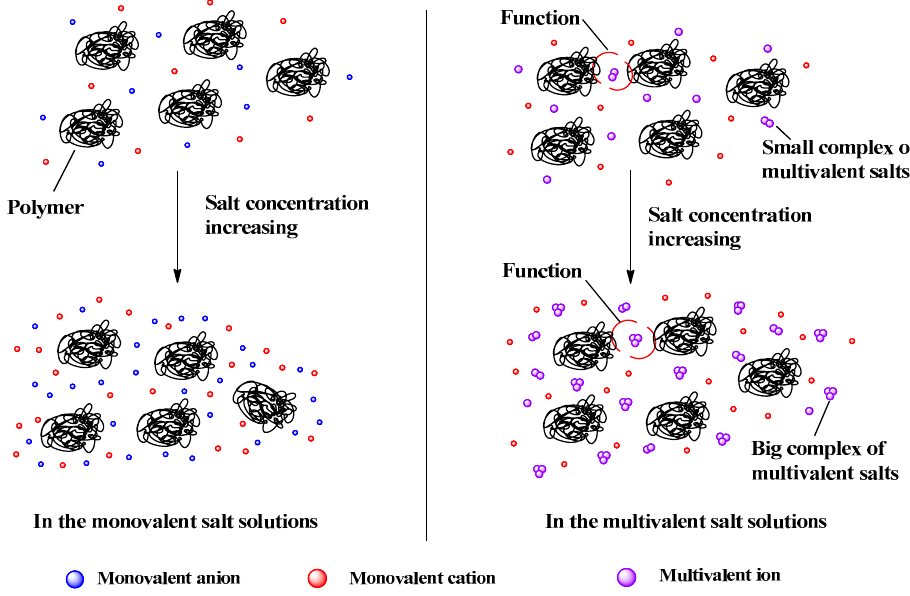
Figure 6. The aggregation model of cationic polymers in salt solutions [91].